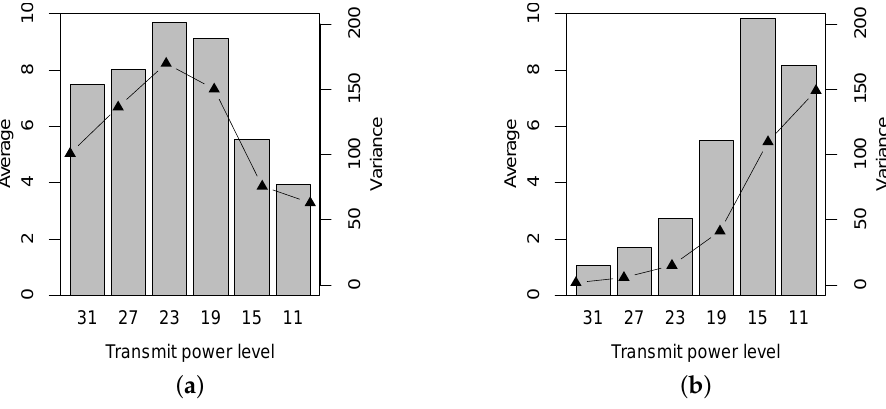
Figure 9. The asymmetry ( D lqi ) of LQI under two different forest environments. ( a ) Bajia; ( b ) Campus.